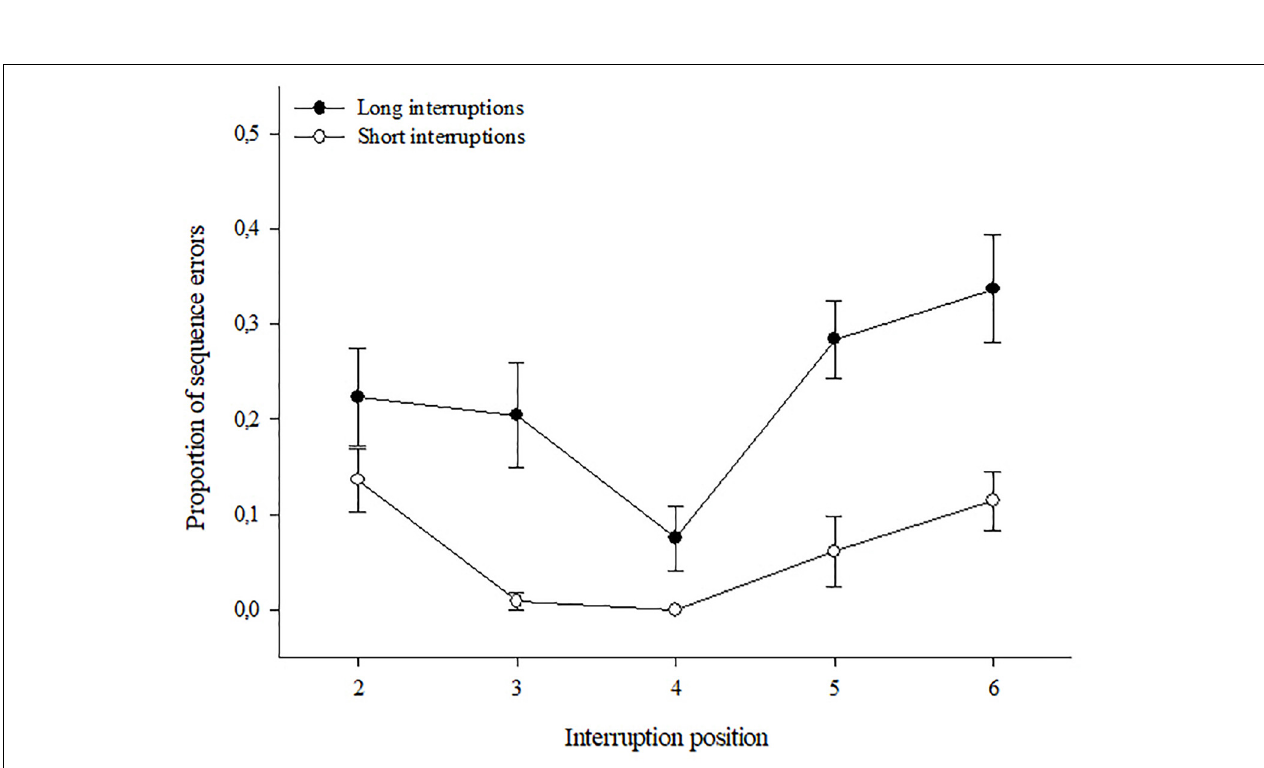
FIGURE 5 | Proportion of sequence errors and standard errors for short and long interruption length at different interruption